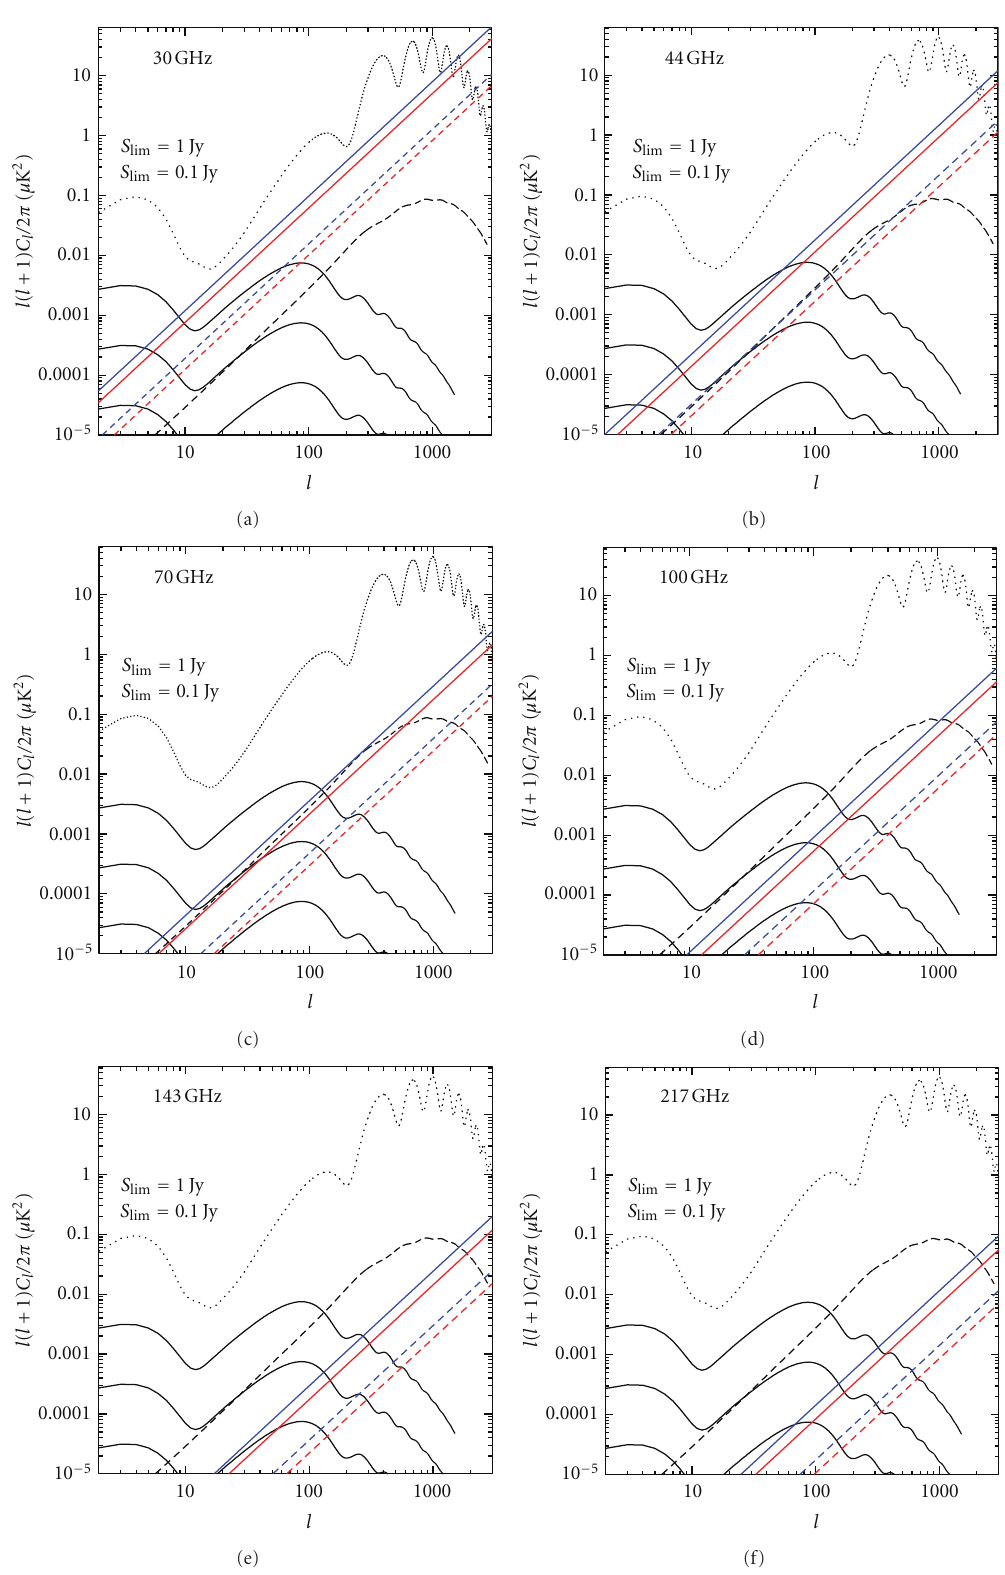
Figure 7: Polarization power spectra at six Planck frequencies for the CMB radiation (black lines: dotted lines for the E-mode; solid lines for the gravitational wave B-mode with r = 0 . 1, 0.01 and 0.001; dashed lines for the lensing-induced B-mode) and for ERS (solid lines are for S . 1Jy; blue lines correspond to the more “conservative” case and red lines to the more “optimistic” S c = 1Jy and dashed lines for c = 0